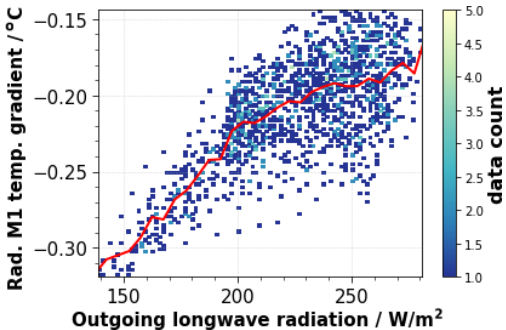
Figure 6. Correlation between the radial M1 mirror temperature gradient and the daily-averaged TOA outgoing longwave radiation measured by the HIRS instrument on board several NOAA satel- lites on 1 October 2019 (Lee and NOAA CDR Program, 2011). The red line shows the radial M1 temperature gradient as a function of the outgoing longwave radiation as binned averages (5Wm − 2 bin